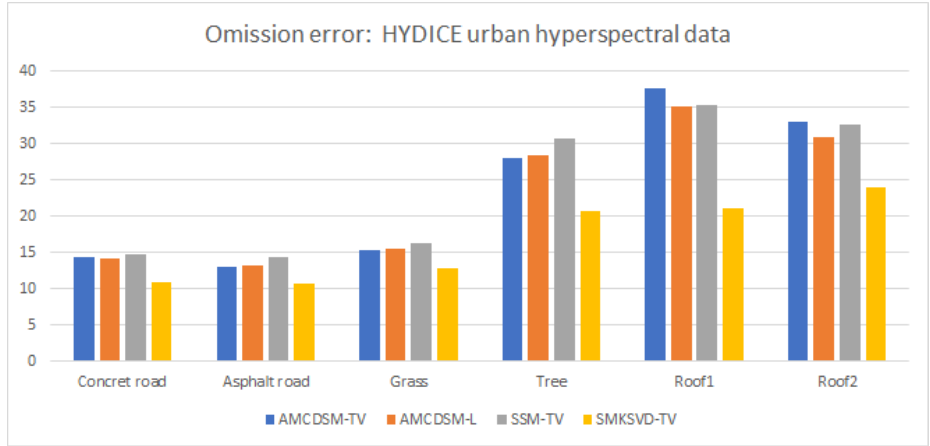
Figure 12. HYDICE urban: omission error rates.